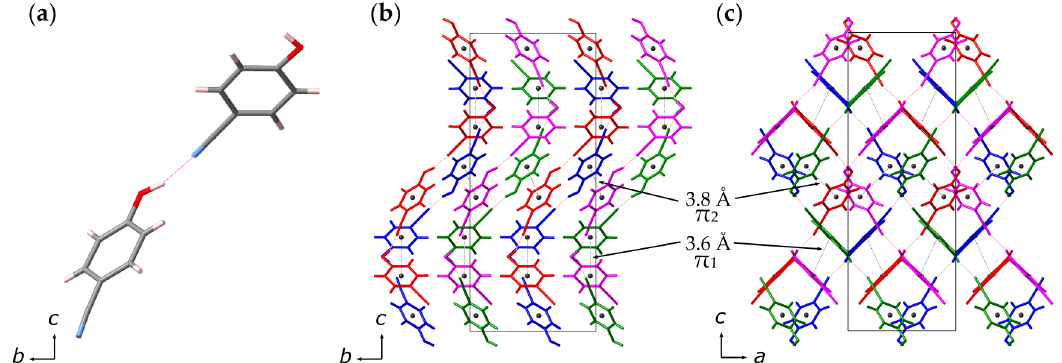
Figure 1. ( a ) Asymmetric unit of the two 4HCB molecules at ambient conditions. The colours represent the different atoms, where grey is C, red is O, blue is N, and pale pink is H. The hydrogen bonding is shown by the dotted red line. Extended structures of 4HCB with the hydrogen bonded connection of 4HCB molecules in one dimension is highlighted with different colours and viewed down the ( b ) a -axis and ( c ) b -axis. Benzene ring centroids are shown by the dark grey spheres, with the π − π interactions highlighted with dotted grey